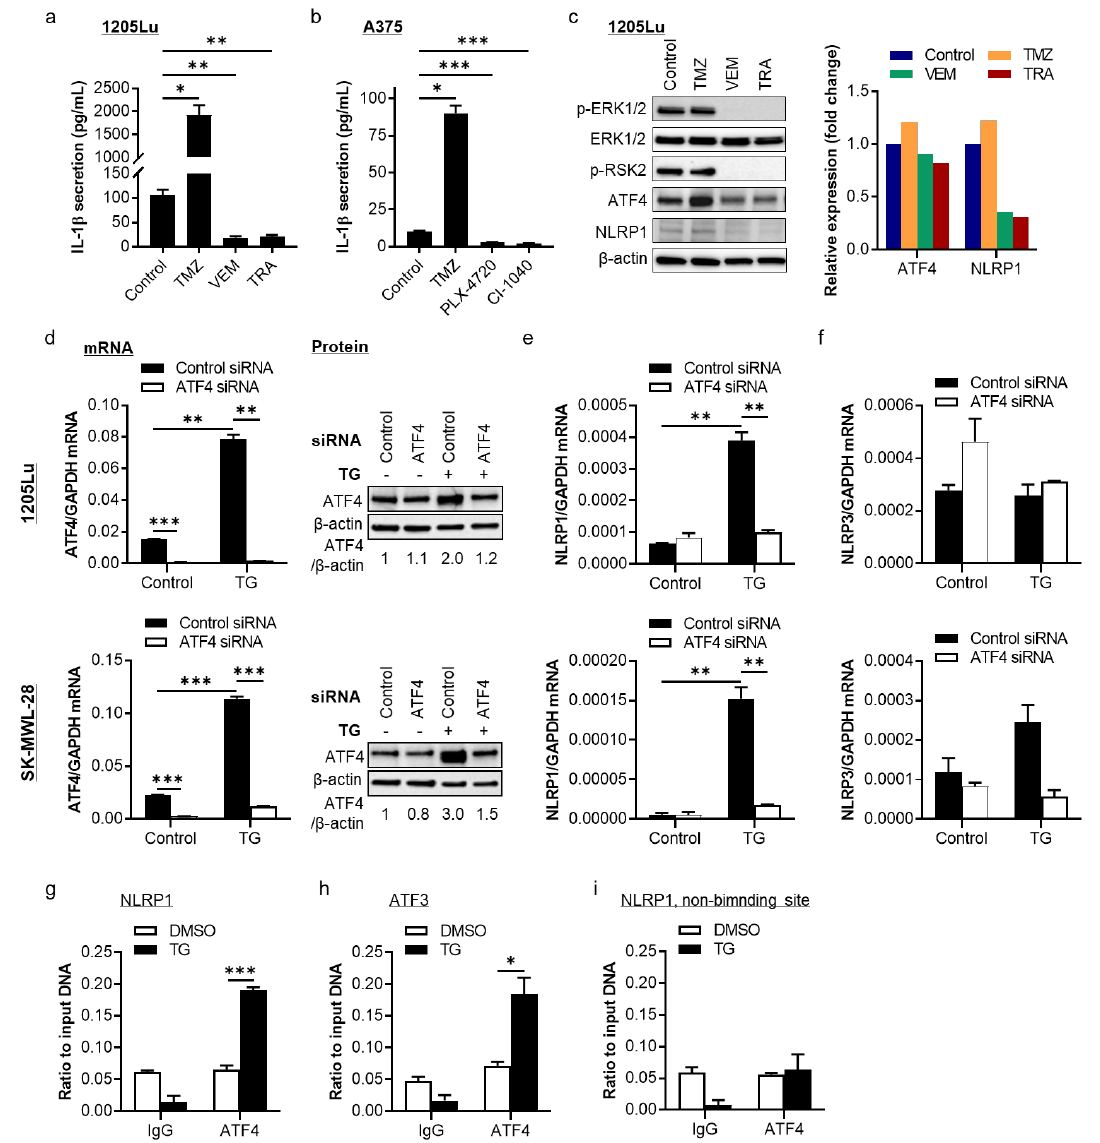
Figure 1. Regulation of NACHT, LRR, and PYD domains-containing protein 1 ( NLRP1 ) by the mitogen-activated protein kinase (MAPK)/extracellular signal-regulated kinase (ERK) pathway through activating transcription factor 4 (ATF4). ( a ) ELISA assay of IL-1β secretion from 1205Lu cells treated with 100 µM temozolomide (TMZ), 1 µM vemurafenib (VEM), or 0.5 µM trametinib (TRA) for 24 h. ( b ) IL-1β secretion from A375 cells treated with 200 µM TMZ, 0.1 µM PLX-4720, or 0.05 µM CI-1040 for 24 h. ( c ) Western blot analysis of ERK and RSK2 phosphorylation as well as ATF4 and NLRP1 expression in 1205Lu cells treated with dimethyl sulfoxide (DMSO, control), 100 µM TMZ, 5 µM VEM, or 0.5 µM TRA for 24 h. The band densities of ATF4 and NLRP1 were quantitated and normalized to those of the corresponding loading control β-actin (right panel). ( d – f ) 1205Lu (top panels) and SK-MEL-28 (bottom panels) cells were transfected with 50 nM control siRNA or ATF4 siRNA overnight and treated with 1 µM thapsigargin (TG), an endoplasmic reticulum (ER) stress inducer, for another 18 h. ( d ) ATF4 mRNA (left panel) and protein expression (right panel) analyzed by qRT-PCR and Western blot, respectively. The band densities of ATF4 were quantitated and normalized to those of the corresponding loading control β-actin. ( e ) NLRP1 mRNA expression. (f) NLRP3 mRNA expression. ( g – i ) ATF4 binds to the NLRP1 gene promoter in metastatic melanoma SK-MEL-28 cells. SK-MEL-28 cells were treated with DMSO or 1 µM TG for 18 h, and chromatin immunoprecipitation (ChIP) assay was performed to evaluate the protein-DNA interaction, followed by qRT-PCR analysis of ATF4 occupancy at the NLRP1 promoter ( g ). ( h ) ATF3 was used as a positive control of ATF4 genomic targets. ( i ) The region 2 kb away from the putative binding site was used as a negative control. Representative images are shown and data expressed as the mean ± SEM, n = 3. * p < 0.05, ** p < 0.01, and *** p < 0.001.